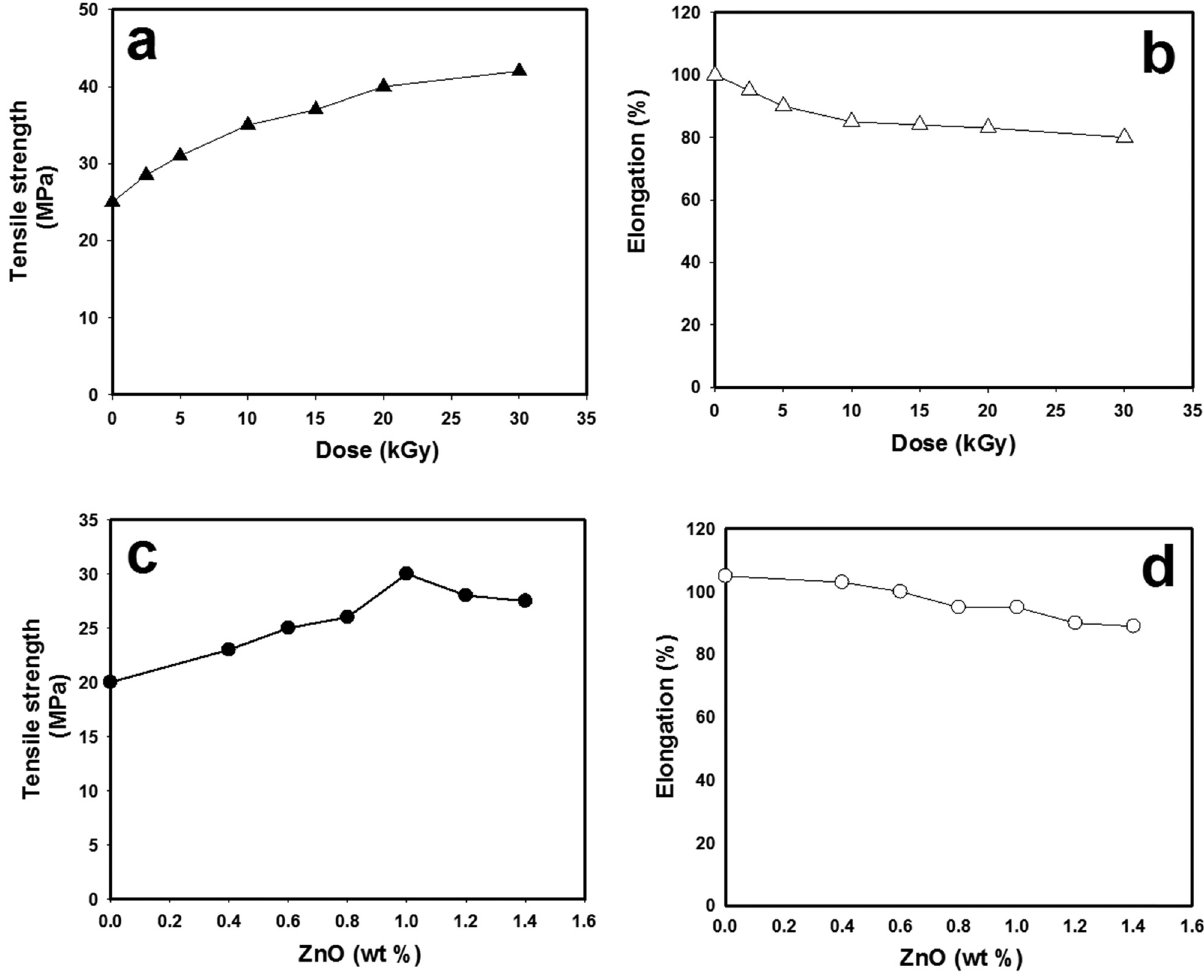
Figure 7: E ff ect of irradiation dose on the mechanical properties of ( PVP:CMC ) /CA/G composites: ( a ) tensile strength and ( b ) elongation percentage. E ff ect of ZnO - NPs concentration on the mechanical properties of ( PVP:CMC ) /CA/G/ZnO nano fi lms: ( c ) tensile strength and ( d )